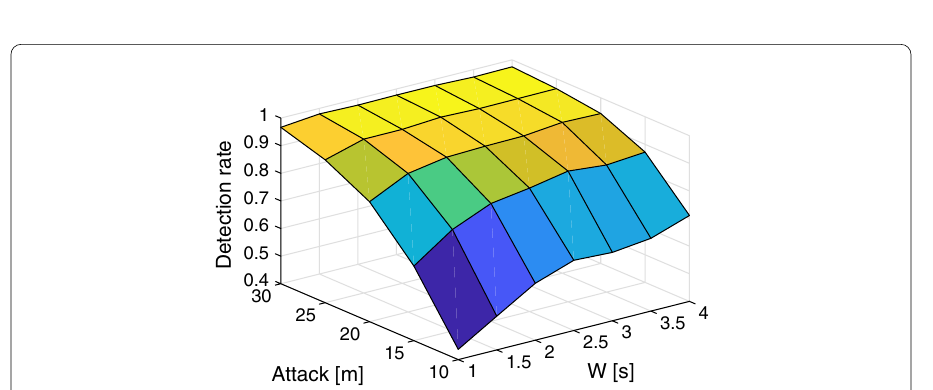
Fig. 10 Attack detection rate depending on algorithm